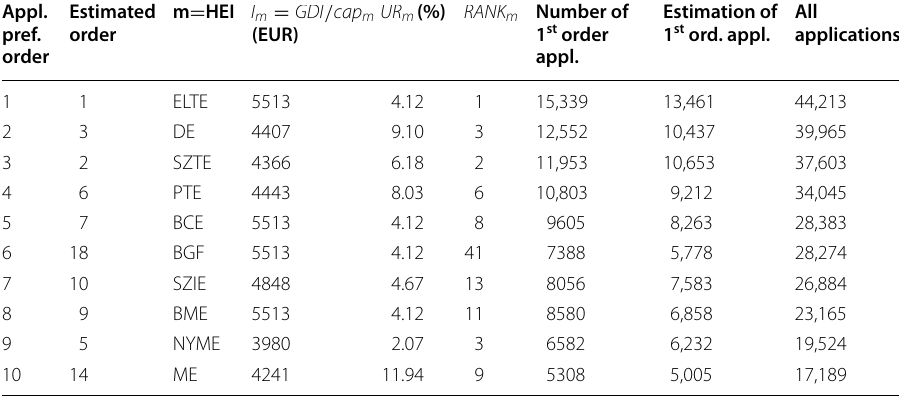
Table 8 Estimation of application preference (2011) Appl.